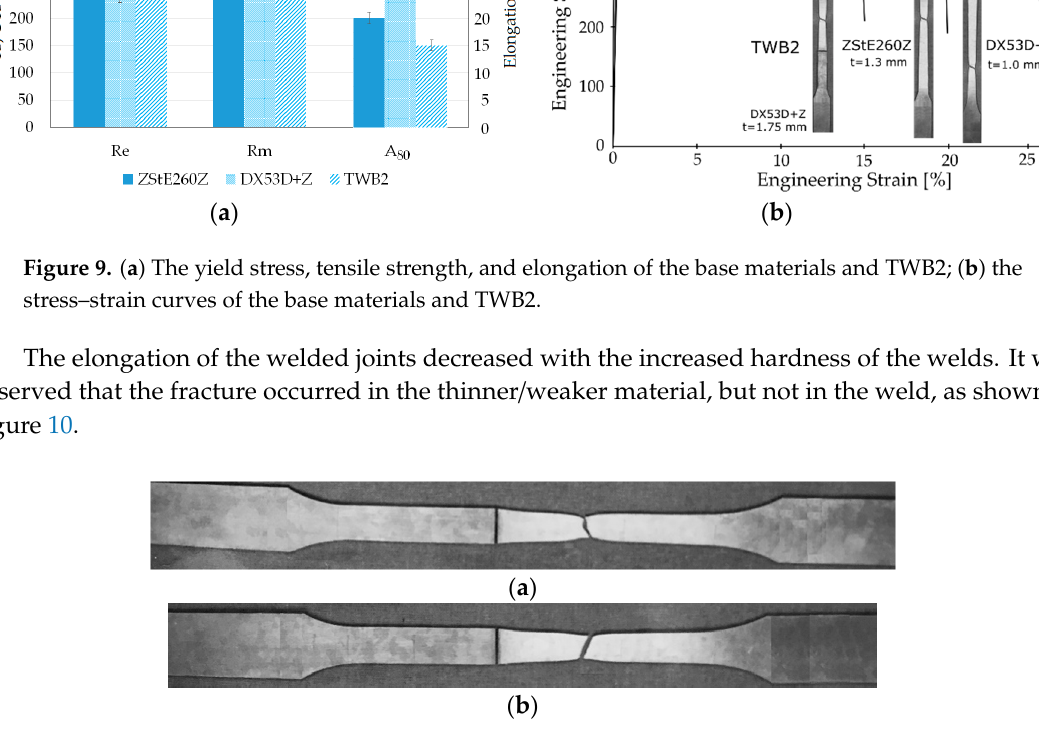
Figure 10. The TWB samples after tensile tests: ( a ) TWB1, ( b ) TWB2.